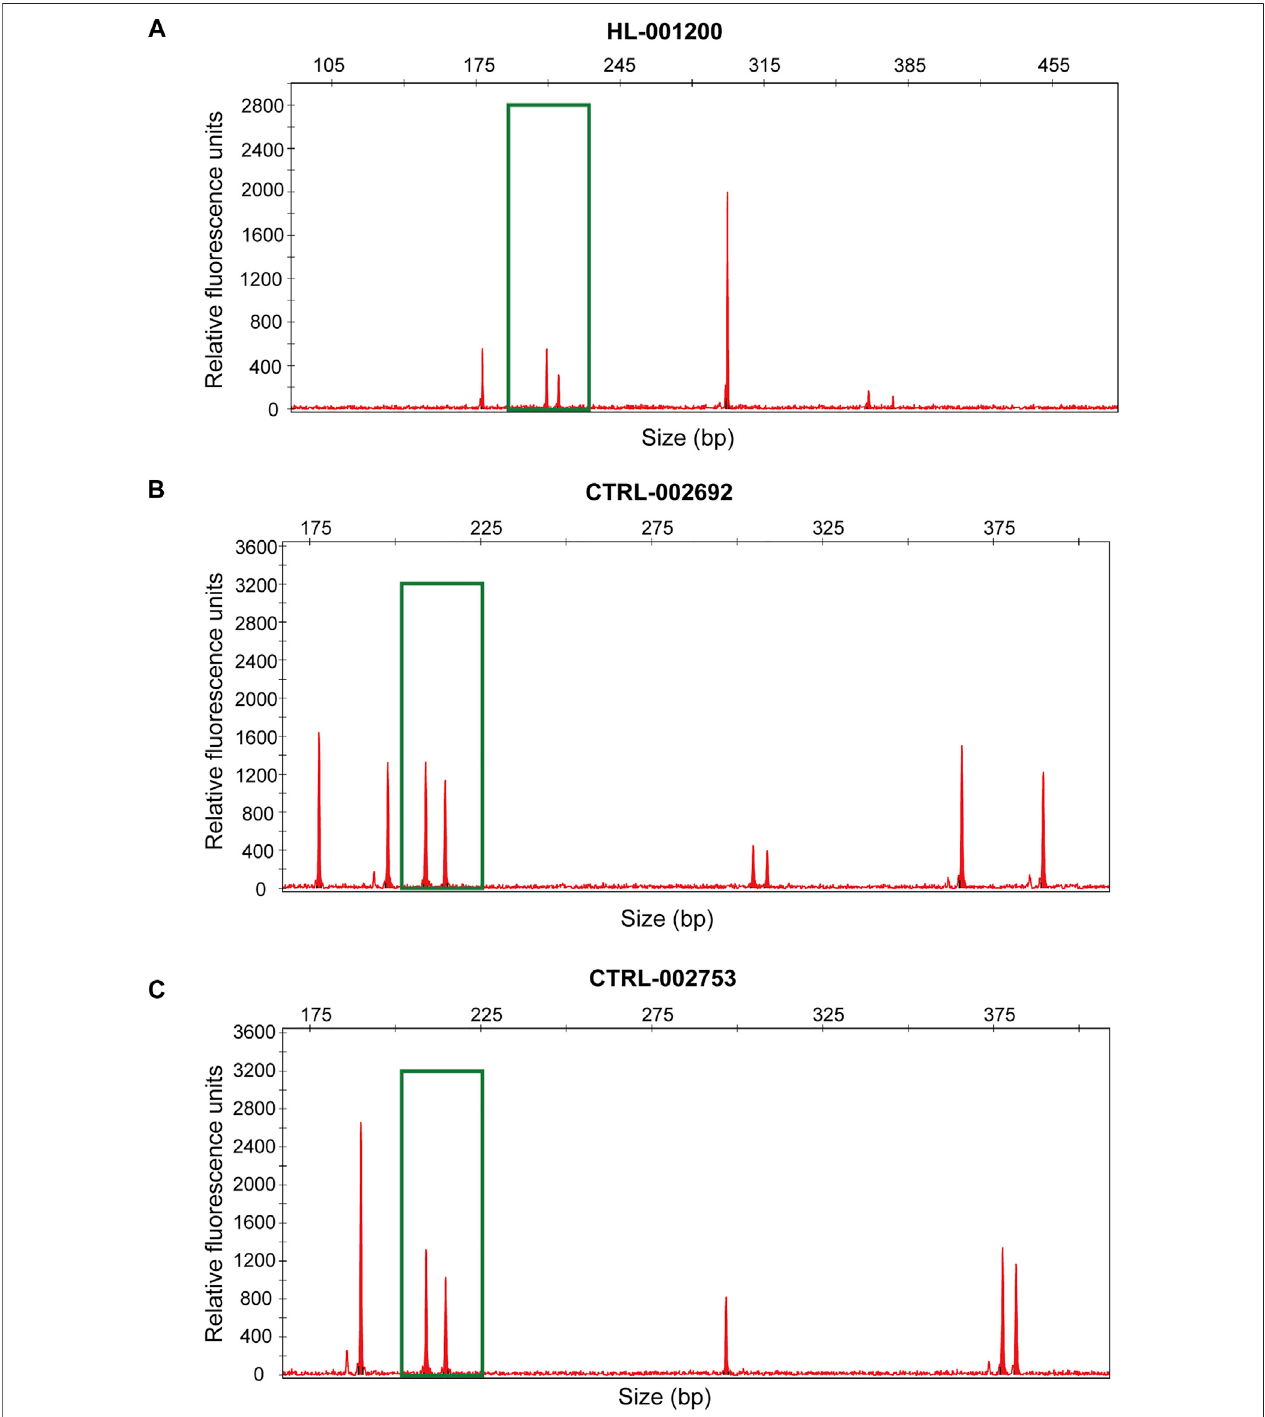
FIGURE 3 | Experimentally veri fi ed gender of HL-001200 (A) , CTRL-002692 (B) and CTRL-002753 (C) . The green box shows the location of the amelogenin loci.